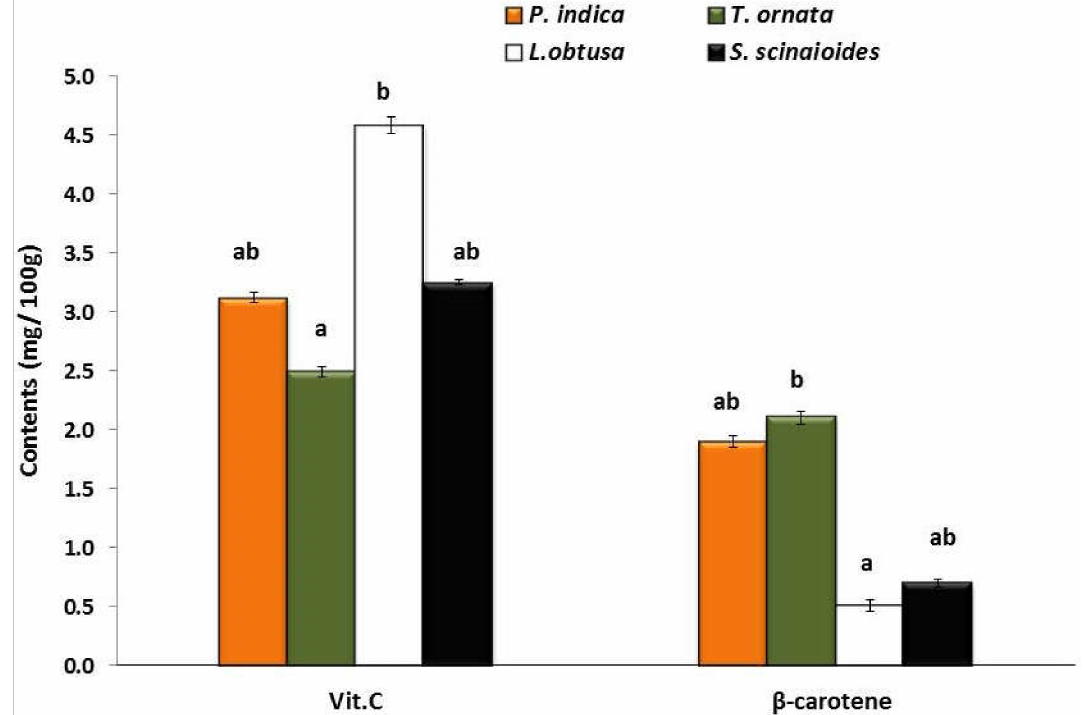
Figure 3. Vitamin C and β -carotene contents (mg/100 g) for studied seaweeds. Values are the mean of three replicates ± standard deviations (SD). Different letters refer to significant differences between species ( p <